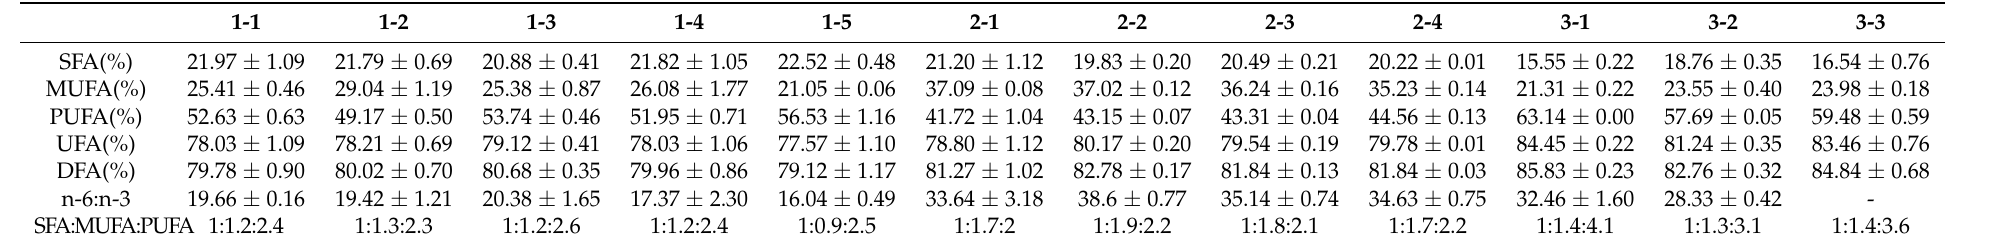
Table 4. Fatty acid composition analysis of fresh sweet-waxy corn from different producing